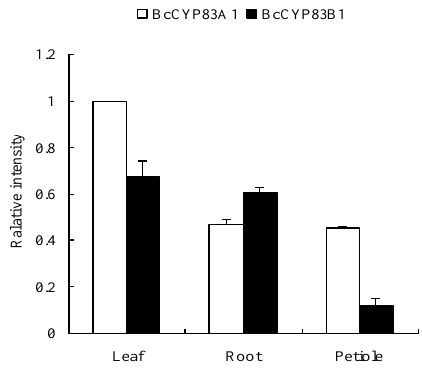
Figure 5. Relative expression analysis of CYP83A1 and CYP83B1 in leaf, petiole and root of pak choi cv. HZYDE. Error bars represent the standard deviation (SD) from three biological